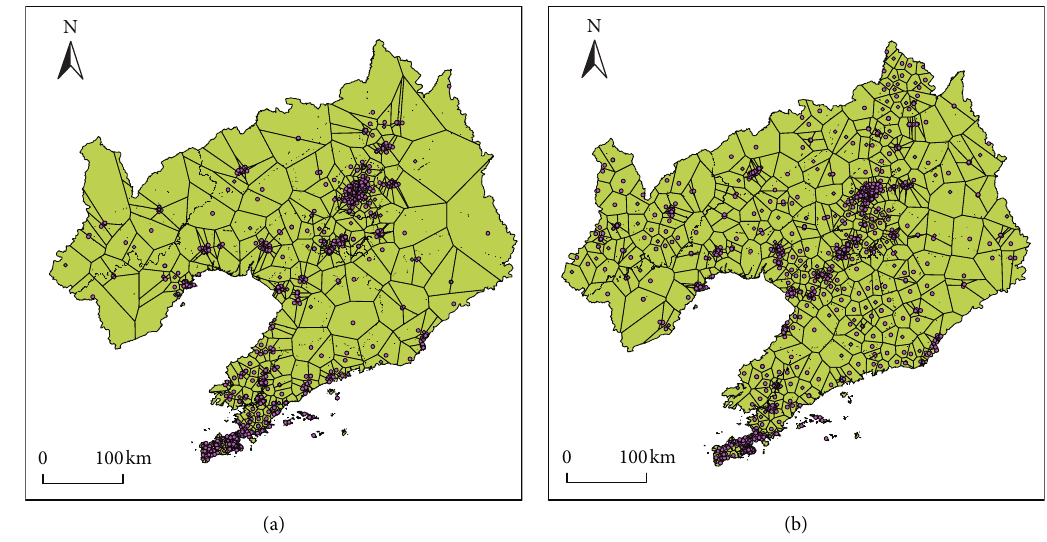
Figure 5: Voronoi maps of primary schools in Liaoning Province (a) in 2008 and (b) in 2017.